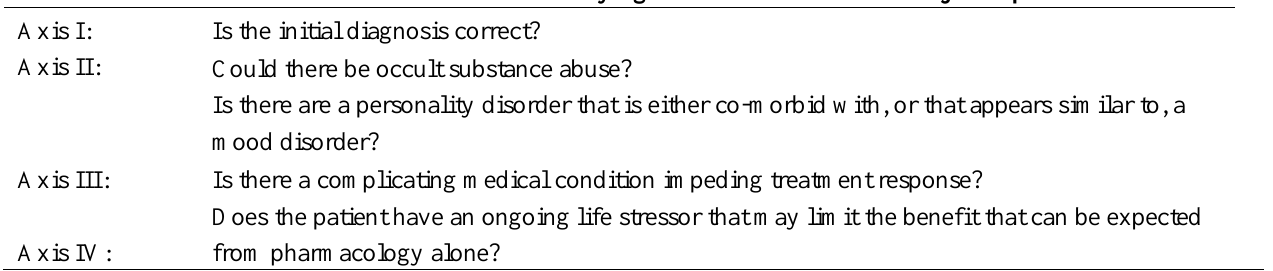
Table 1. Running the Axes